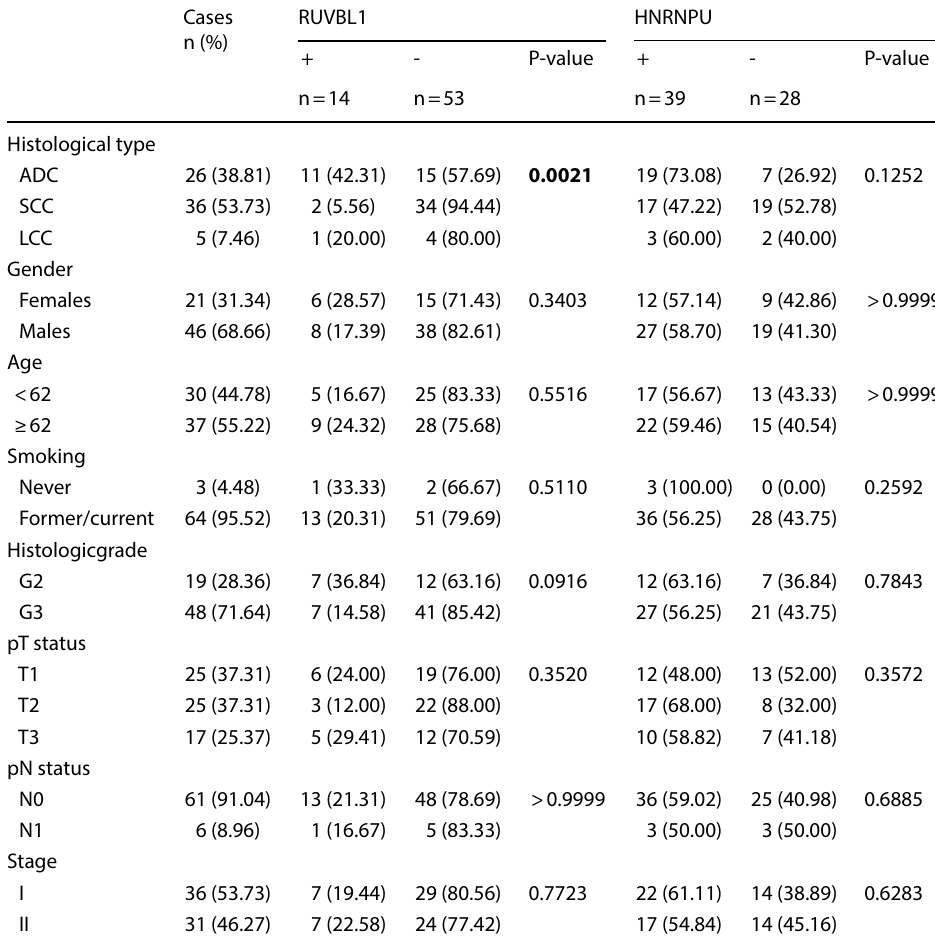
Table 1 Association of RUVBL1 and HNRNPU, and clinicopathological features in our cohort of NSCLC patients (n =